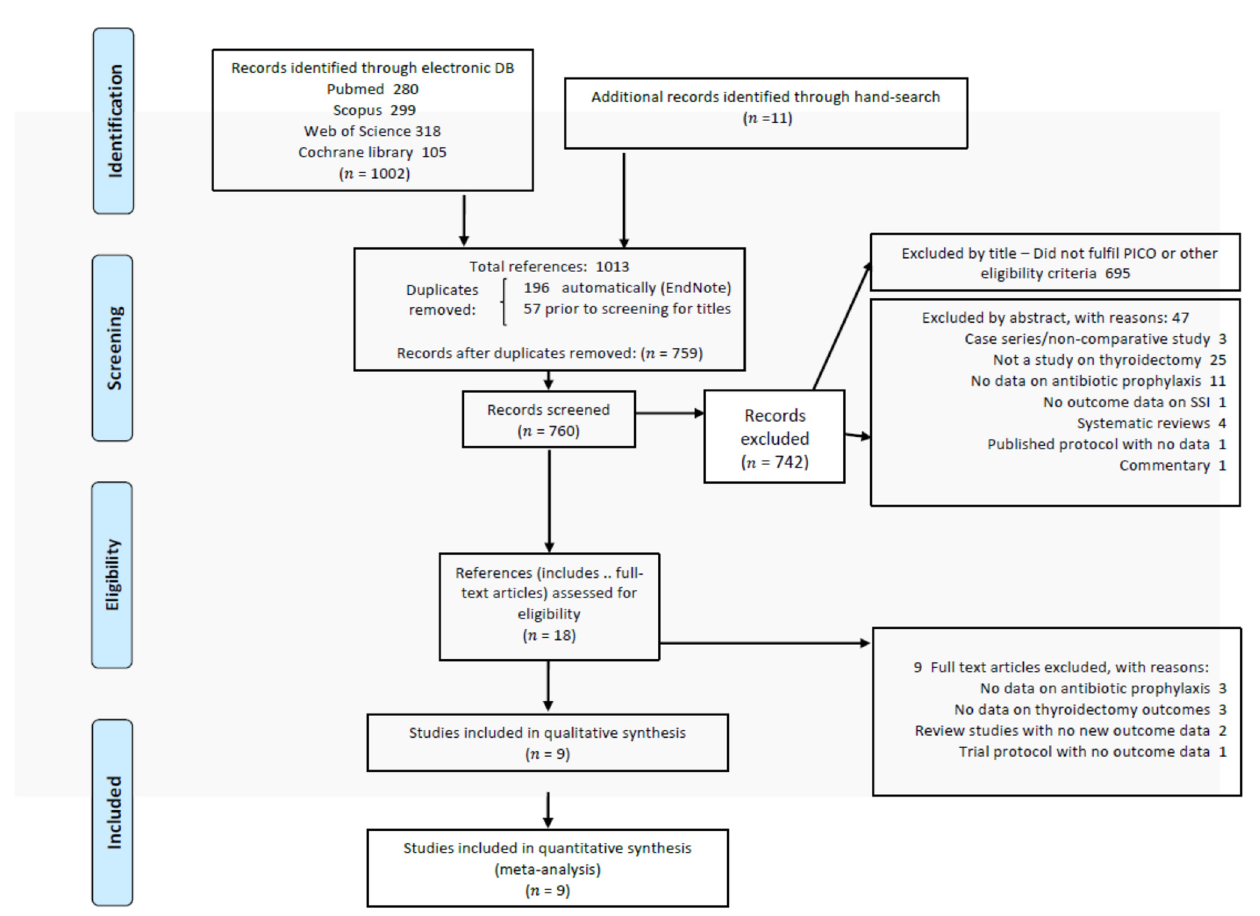
Figure 1. PRISMA flow chart of search results and selection of studies.